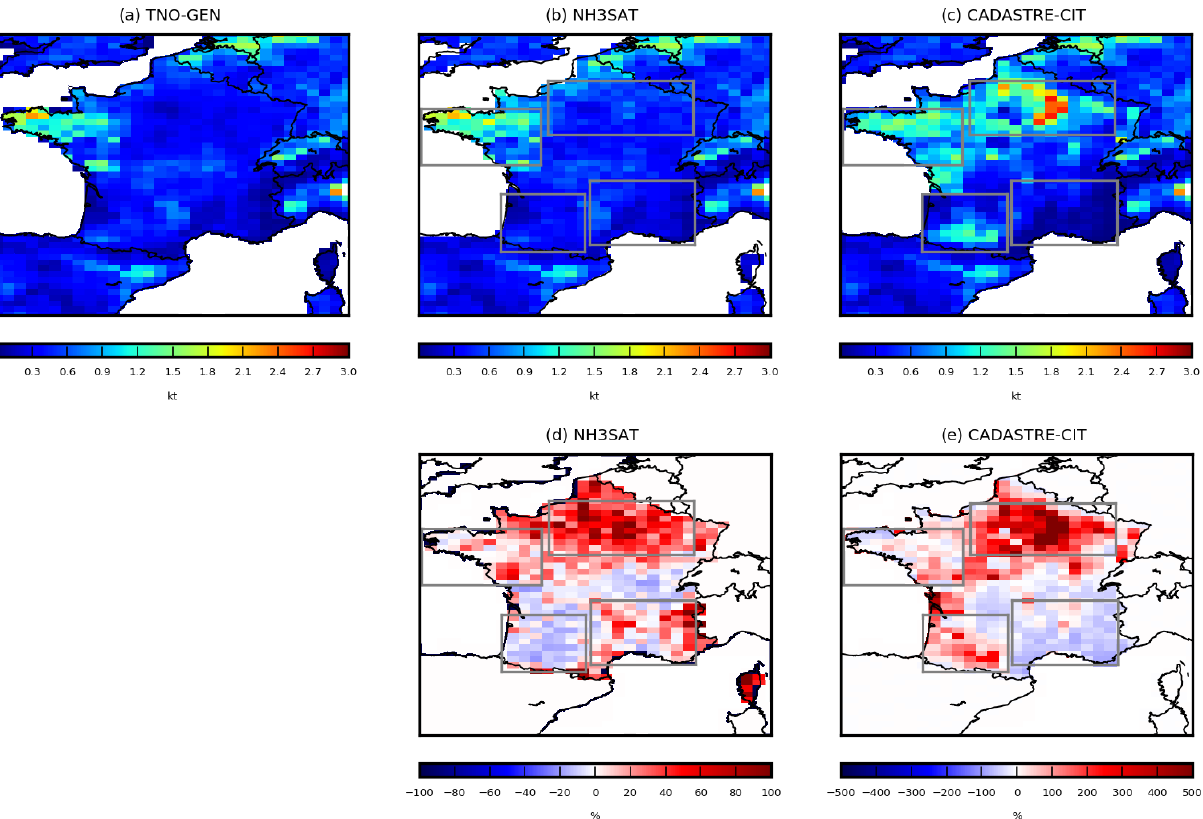
Figure 4. French NH 3 spring emissions estimated by (a) the TNO-GEN inventory, (b) the NH 3 SAT inventory and (c) the CADASTRE- CIT inventory, in kilotons of NH 3 (ktNH 3 ). Relative differences of (d) the NH 3 SAT, and (e) the CADASTRE-CIT inventories compared to the TNO-GEN inventory, in percentage, at the pixel resolution, for the period from March to May 2011. Note that the scale is different between (b) and (c)